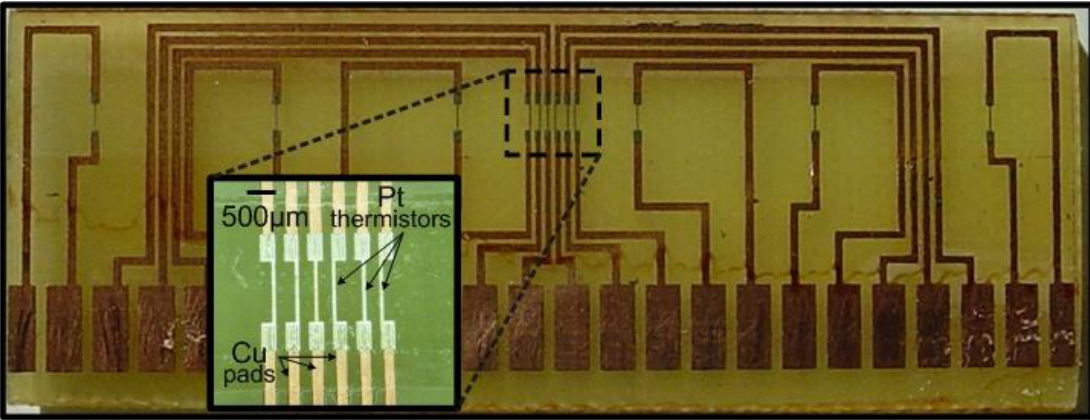
Figure 1. A photograph of the fabricated sensor. At the inset, an enlarged image of the dense part of the multiple resistor pattern is